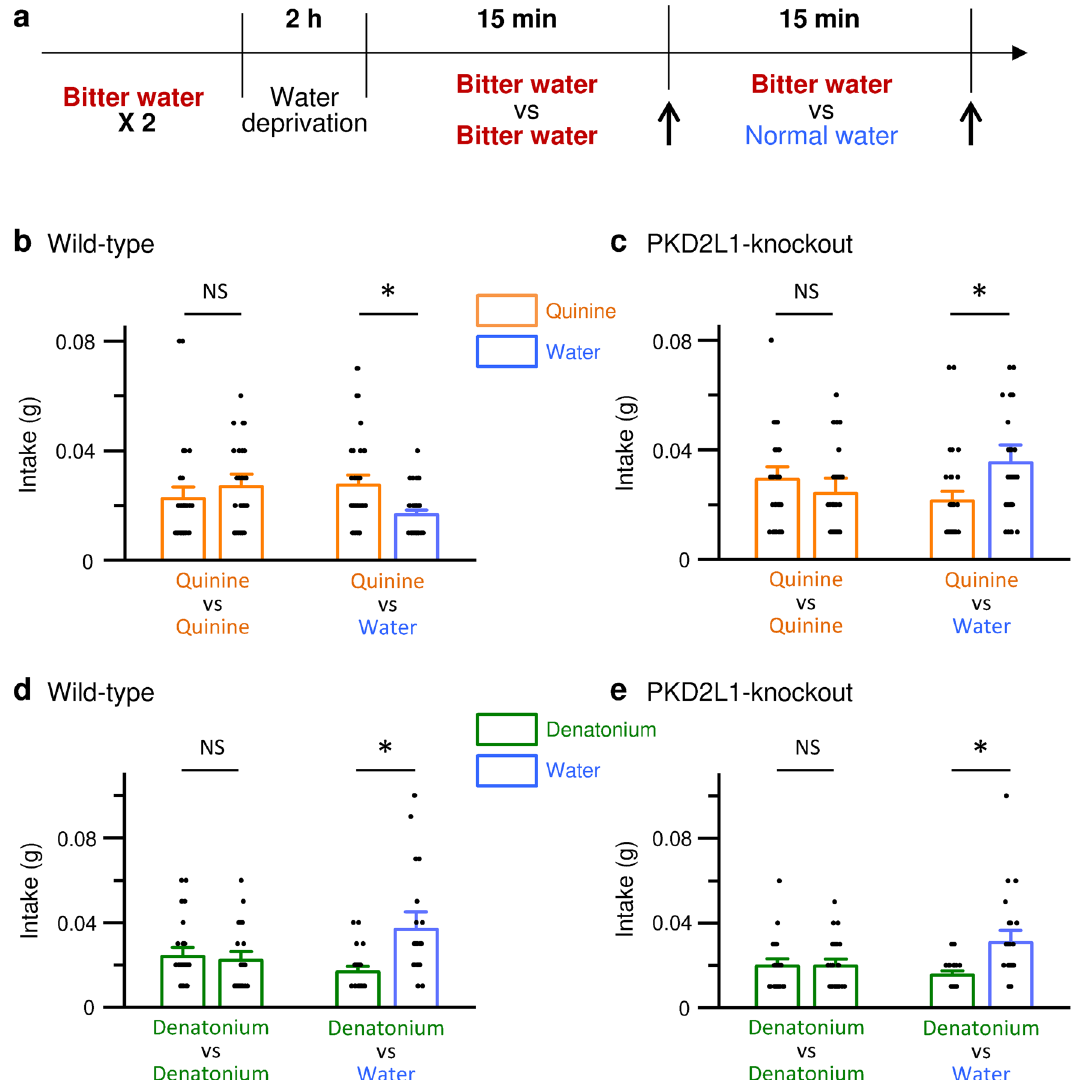
Figure 5. Intakes of quinine- or denatonium-containing water in short-term two-bottle preference tests in mice. ( a ) Timeline of experimental protocols. Arrows indicate the timing that two bottles were replaced and the intake was measured. ( b – e ) Mean intakes of 30 µM quinine- ( b , c ) or 500 µM denatonium- ( d , e ) containing water and normal water in the wild-type ( b , d ) or the PKD2L1-knockout ( c , e ) mice. Two bottles of bitterant- containing water were initially presented for 15 min and then bitterant-containing water and normal water were given for another 15 min. The data are averaged from 26 to 47 experiments. P values are determined by Wilcoxon signed-rank test (n = 47 in b , n = 39 in c , n = 28 in d , and n = 26 in e ). *, P < 0.05. NS, P >